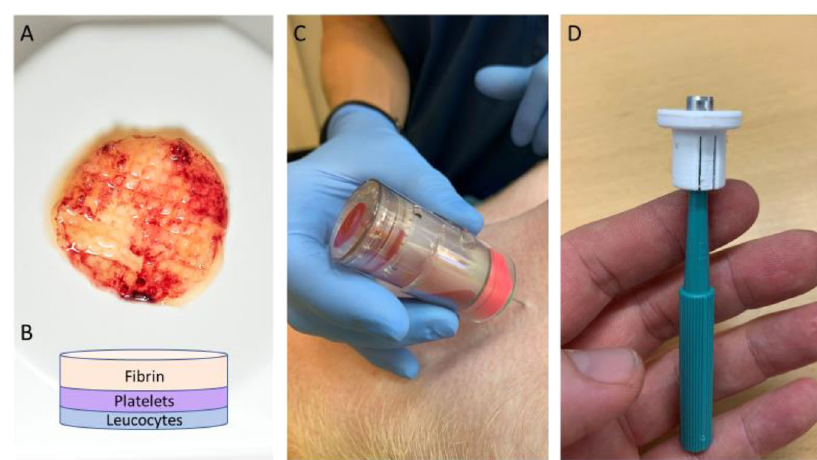
Fig. 1 A An autologous blood- derived patch. B The combined leukocyte, platelet and fi brin structure of the autologous blood-derived patch. C 3C Patch ® Device used with venipuncture in the jugular vein of a pig. D Biopsy punch with stopper